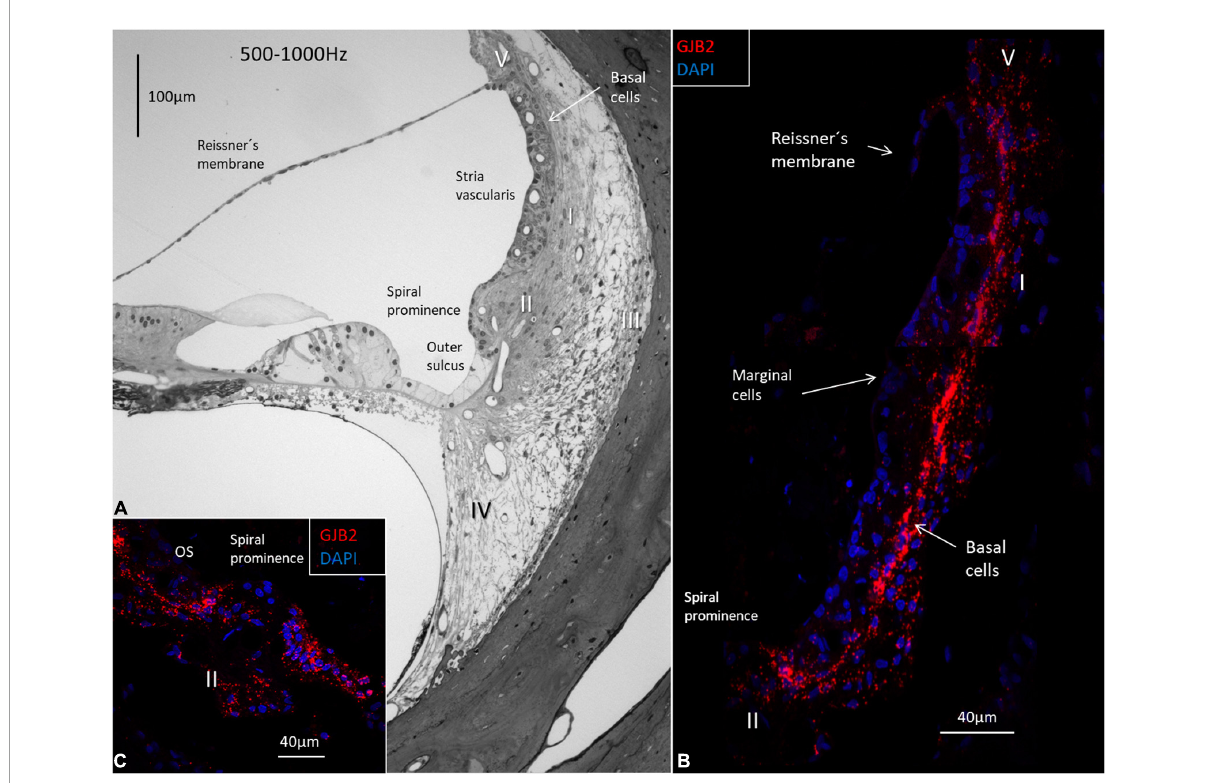
FIGURE5 Light microscopy of the human OC and lateral wall at the frequency region 500-1000 Hz and confocal microscopy of GJB2 . (A) The semi-thin section shows the stria vascularis and the spiral ligament with five different types of fibrocytes (I-V). Basal cells face the type I fibrocytes. The spiral prominence epithelium is thin and changes into a light epithelium in the outer sulcus (OS). (B) A large number of GJB2 gene transcripts are concentrated in the basal cell region. There are no transcripts in the marginal cells. (C) There are few transcripts in the spiral prominence epithelium. A large number of transcripts are seen in the outer